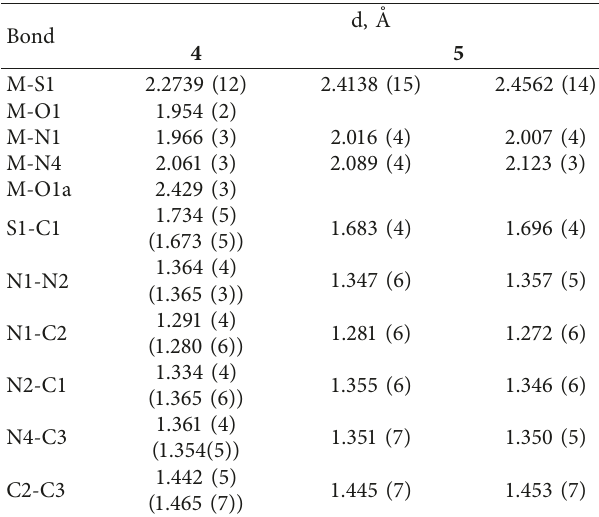
Table 2: Selected bond lengths in 4, 5 , (M � Cu1, Ni1), and HL (in